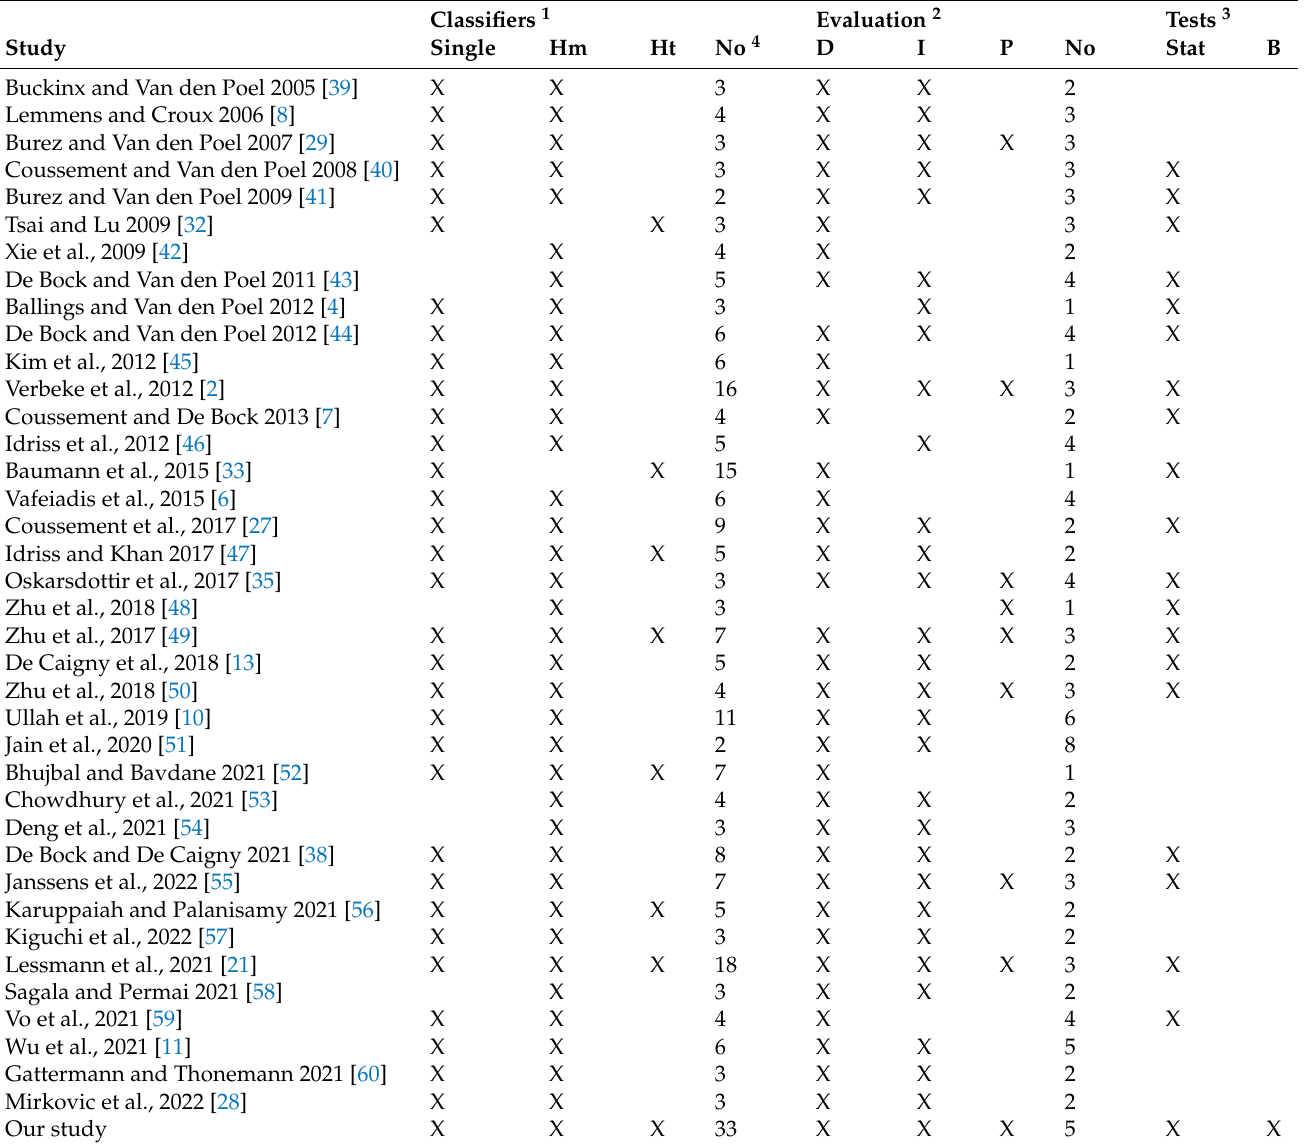
1 The abbreviations stand for: single = single classifiers, Hm = homogeneous ensemble, Ht = heterogeneous ensemble, No = number of classifiers. 2 The abbreviations stand for: D = cut-off dependent measures, I = cut-off independent measures, P = profit-driven measures, No = number of evaluation metrics. 3 The abbreviations stand for: Stat = statistical hypothesis testing, B = Bayesian testing. 4 We only count the number of unique